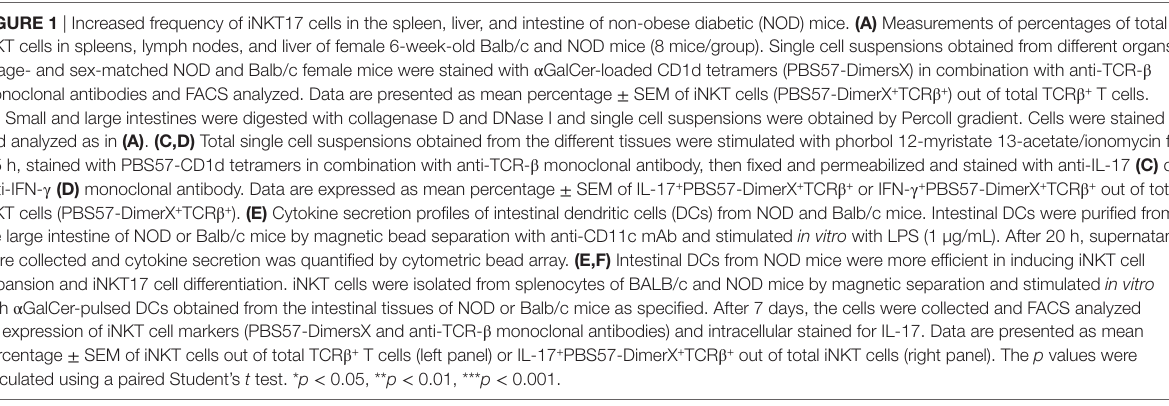
FigUre 1 | Increased frequency of iNKT17 cells in the spleen, liver, and intestine of non-obese diabetic (NOD) mice. (a) Measurements of percentages of total iNKT cells in spleens, lymph nodes, and liver of female 6-week-old Balb/c and NOD mice (8 mice/group). Single cell suspensions obtained from different organs of age- and sex-matched NOD and Balb/c female mice were stained with α GalCer-loaded CD1d tetramers (PBS57-DimersX) in combination with anti-TCR- β monoclonal antibodies and FACS analyzed. Data are presented as mean percentage ± SEM of iNKT cells (PBS57-DimerX + TCR β + ) out of total TCR β + T cells. (B) Small and large intestines were digested with collagenase D and DNase I and single cell suspensions were obtained by Percoll gradient. Cells were stained and analyzed as in (a) . (c,D) Total single cell suspensions obtained from the different tissues were stimulated with phorbol 12-myristate 13-acetate/ionomycin for 2.5 h, stained with PBS57-CD1d tetramers in combination with anti-TCR- β monoclonal antibody, then fixed and permeabilized and stained with anti-IL-17 (c) or anti-IFN- γ (D) monoclonal antibody. Data are expressed as mean percentage ± SEM of IL-17 + PBS57-DimerX + TCR β + or IFN- γ + PBS57-DimerX + TCR β + out of total iNKT cells (PBS57-DimerX + TCR β + ). (e) Cytokine secretion profiles of intestinal dendritic cells (DCs) from NOD and Balb/c mice. Intestinal DCs were purified from the large intestine of NOD or Balb/c mice by magnetic bead separation with anti-CD11c mAb and stimulated in vitro with LPS (1 µg/mL). After 20 h, supernatants were collected and cytokine secretion was quantified by cytometric bead array. (e,F) Intestinal DCs from NOD mice were more efficient in inducing iNKT cell expansion and iNKT17 cell differentiation. iNKT cells were isolated from splenocytes of BALB/c and NOD mice by magnetic separation and stimulated in vitro with α GalCer-pulsed DCs obtained from the intestinal tissues of NOD or Balb/c mice as specified. After 7 days, the cells were collected and FACS analyzed for expression of iNKT cell markers (PBS57-DimersX and anti-TCR- β monoclonal antibodies) and intracellular stained for IL-17. Data are presented as